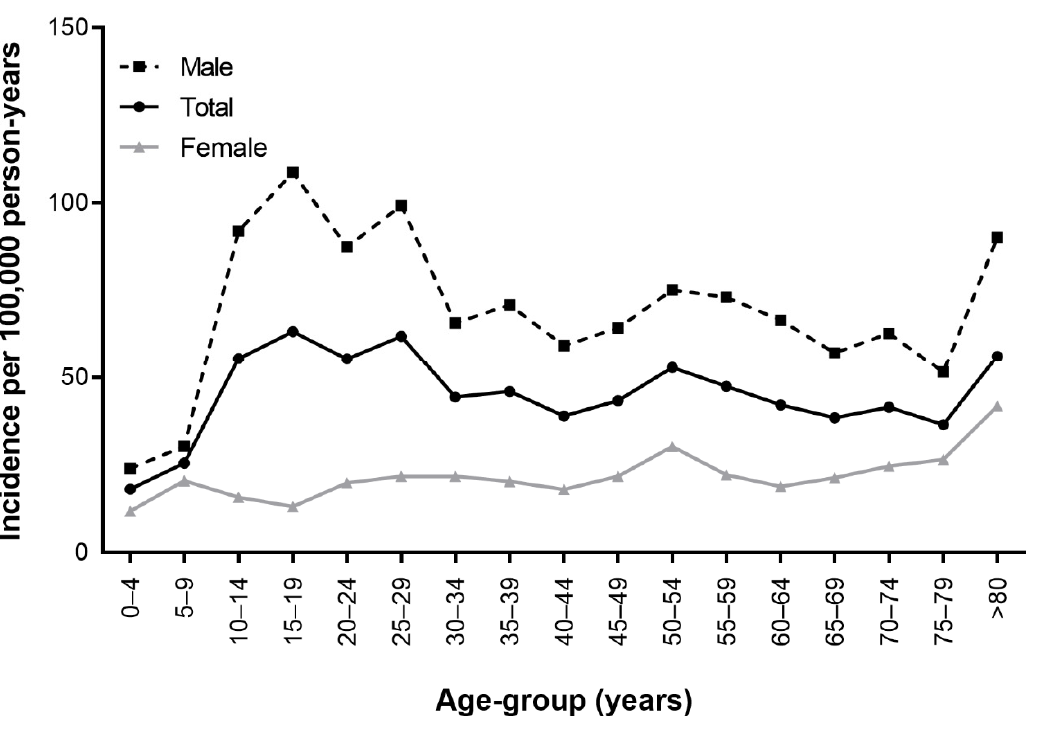
Figure 1. Incidence of orbital wall fractures by age group.